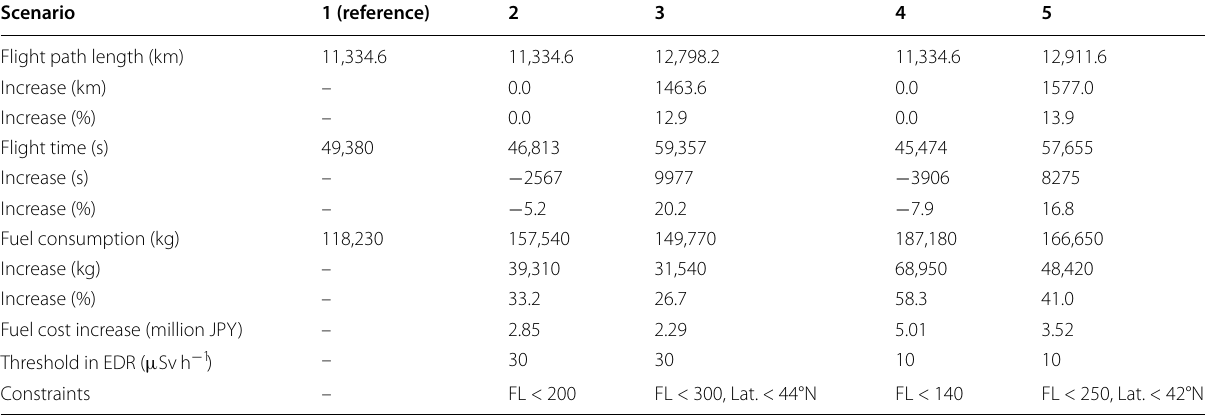
The thresholds in EDR and constraints for each scenario (Table 1) are reproduced for reference